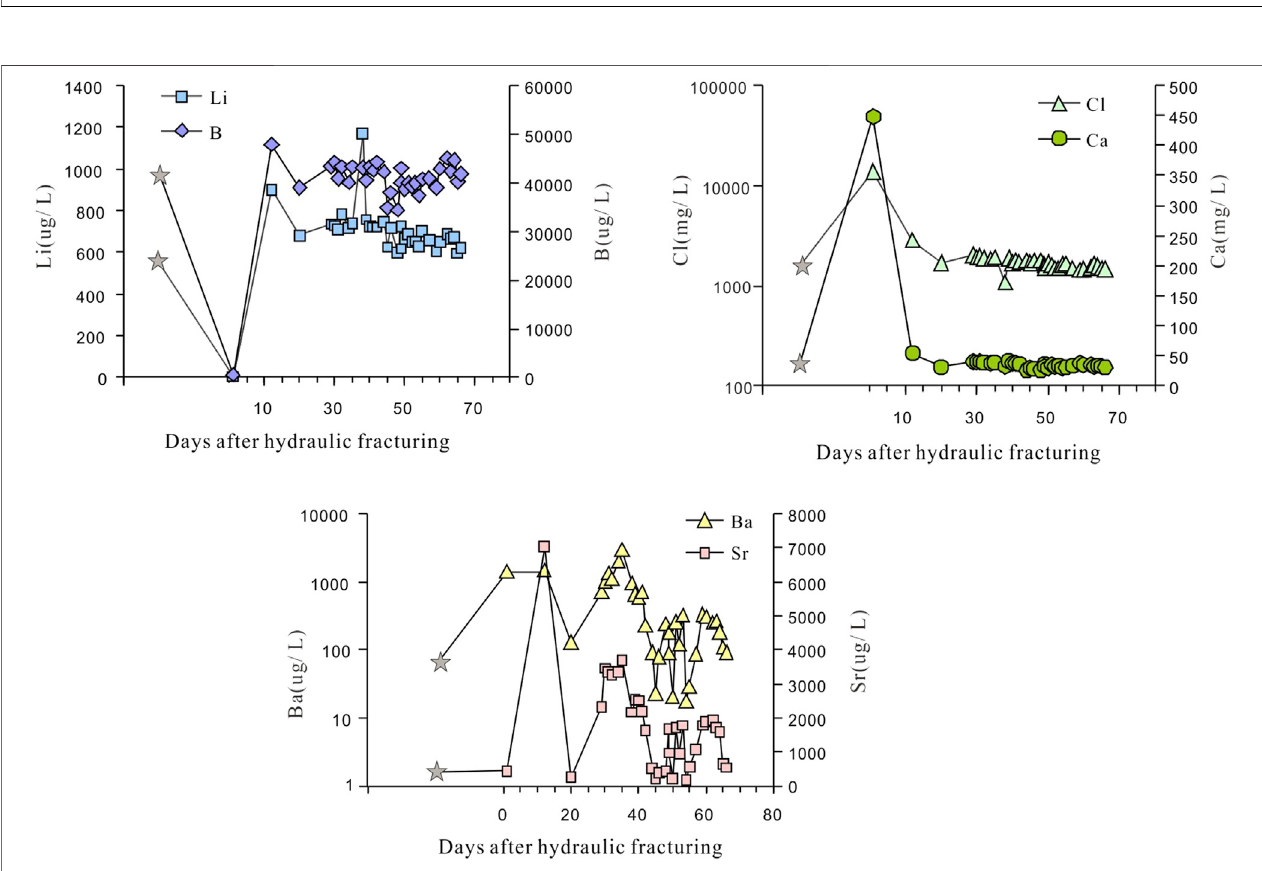
FIGURE10 | Evolution trendof fl owback geochemistry in conventional KaramayFormation (the starsin the diagrams indicate the correspondingcharacteristics of the fracturing fl uid).